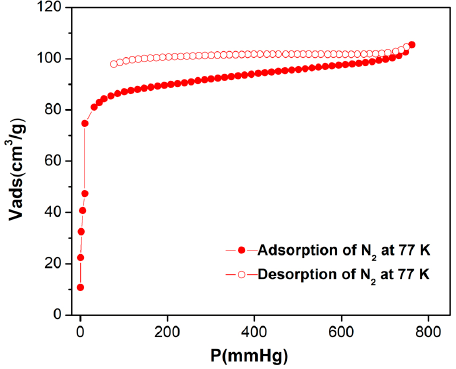
Figure 6. N 2 isotherms at 77 K for complex 1 .